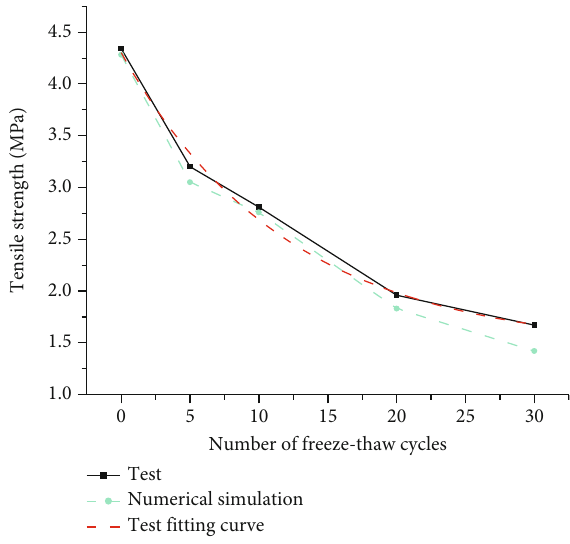
Figure 8: Sandstone tensile strength